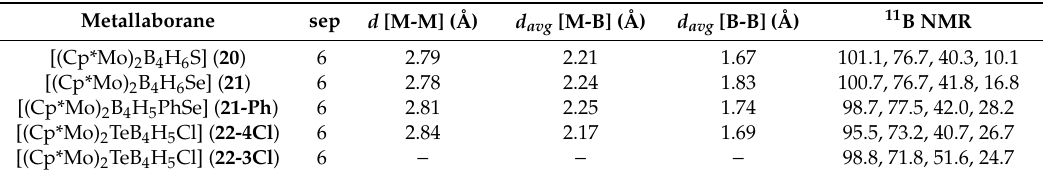
Table 3. Skeletal electron pair count (sep), selected structural parameters, and 11 B chemical shifts of 20 – 22 .